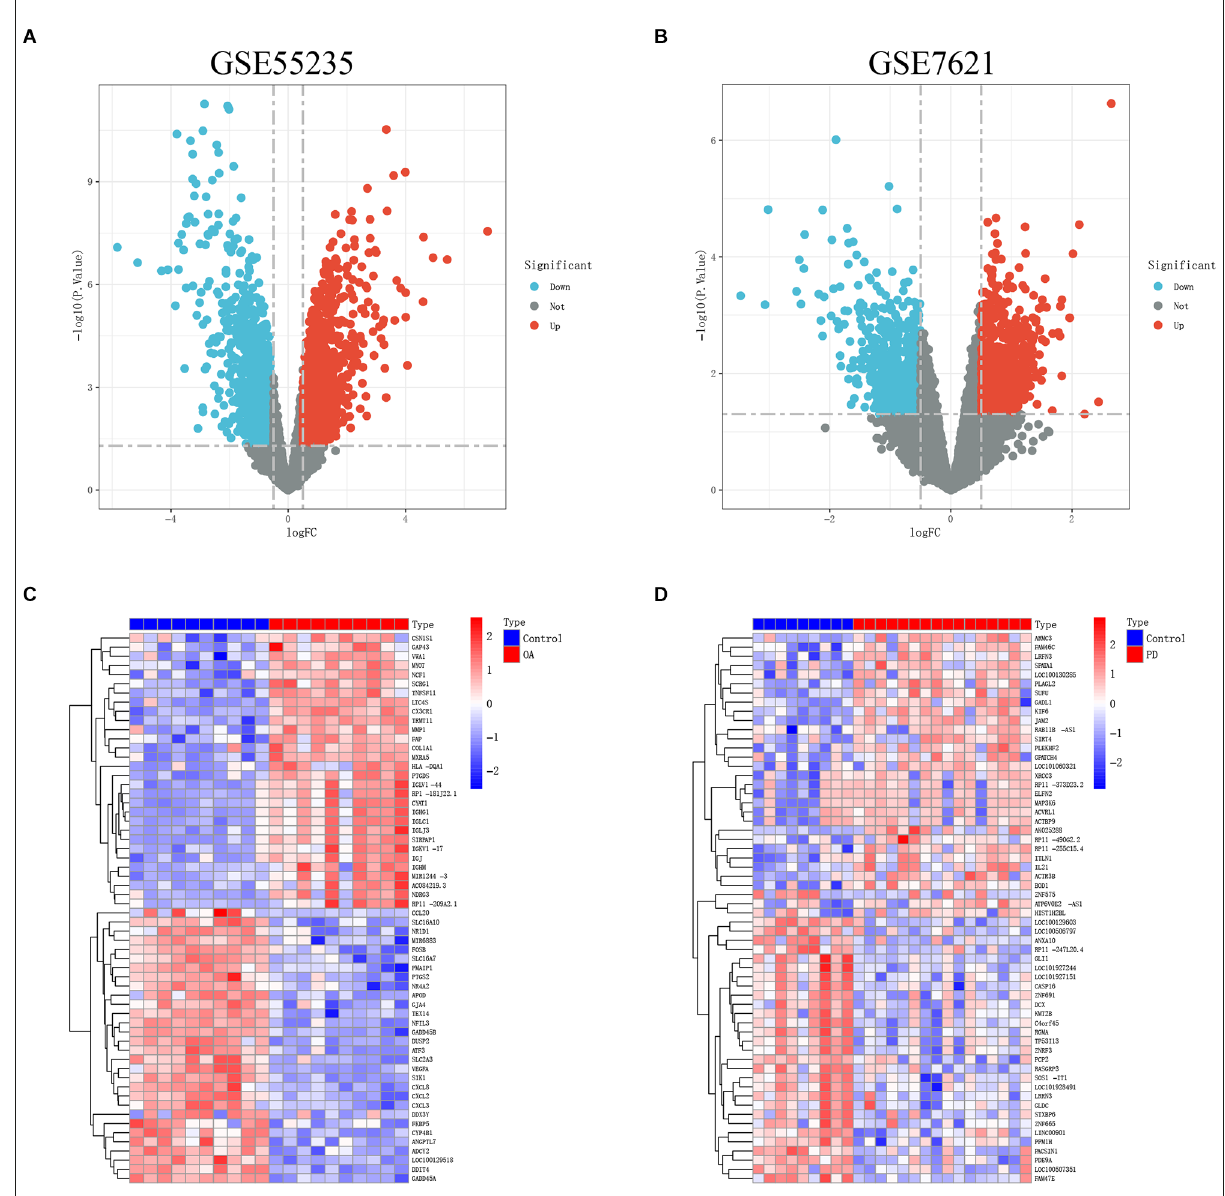
FIGURE2 (A,B) The volcanoes map of GSE55235 and GSE7621. (C,D) The heatmaps of GSE55235 and GSE7621.